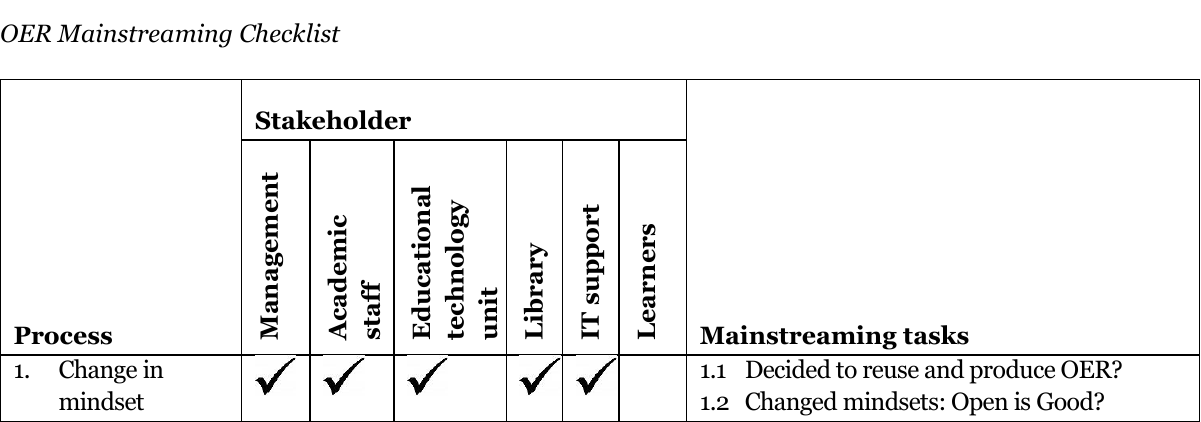
OER Mainstreaming Checklist